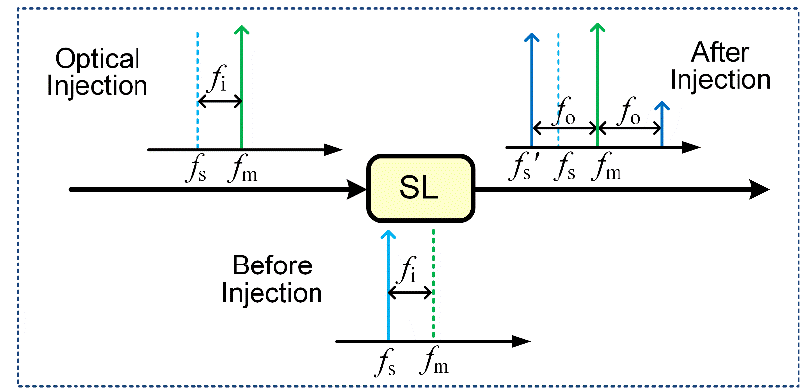
Figure 2. Illustration of typical spectral characteristics of an OSIL in the period-one state.